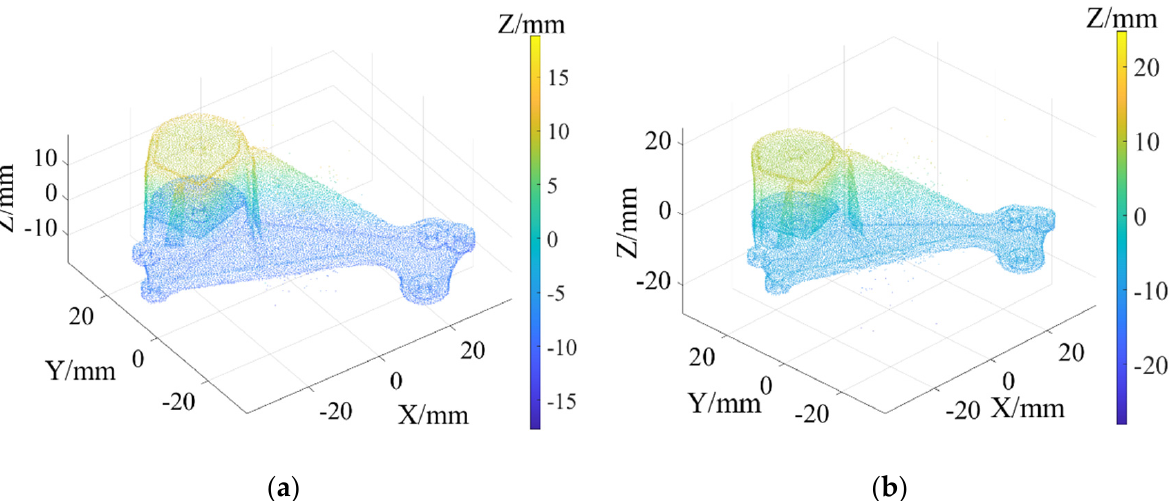
Figure 6. Denoising results of NLD under different noise intensities: ( a ) NLD ( σ = 0.2 ) ; ( b ) NLD ( σ = 0.4 ) .